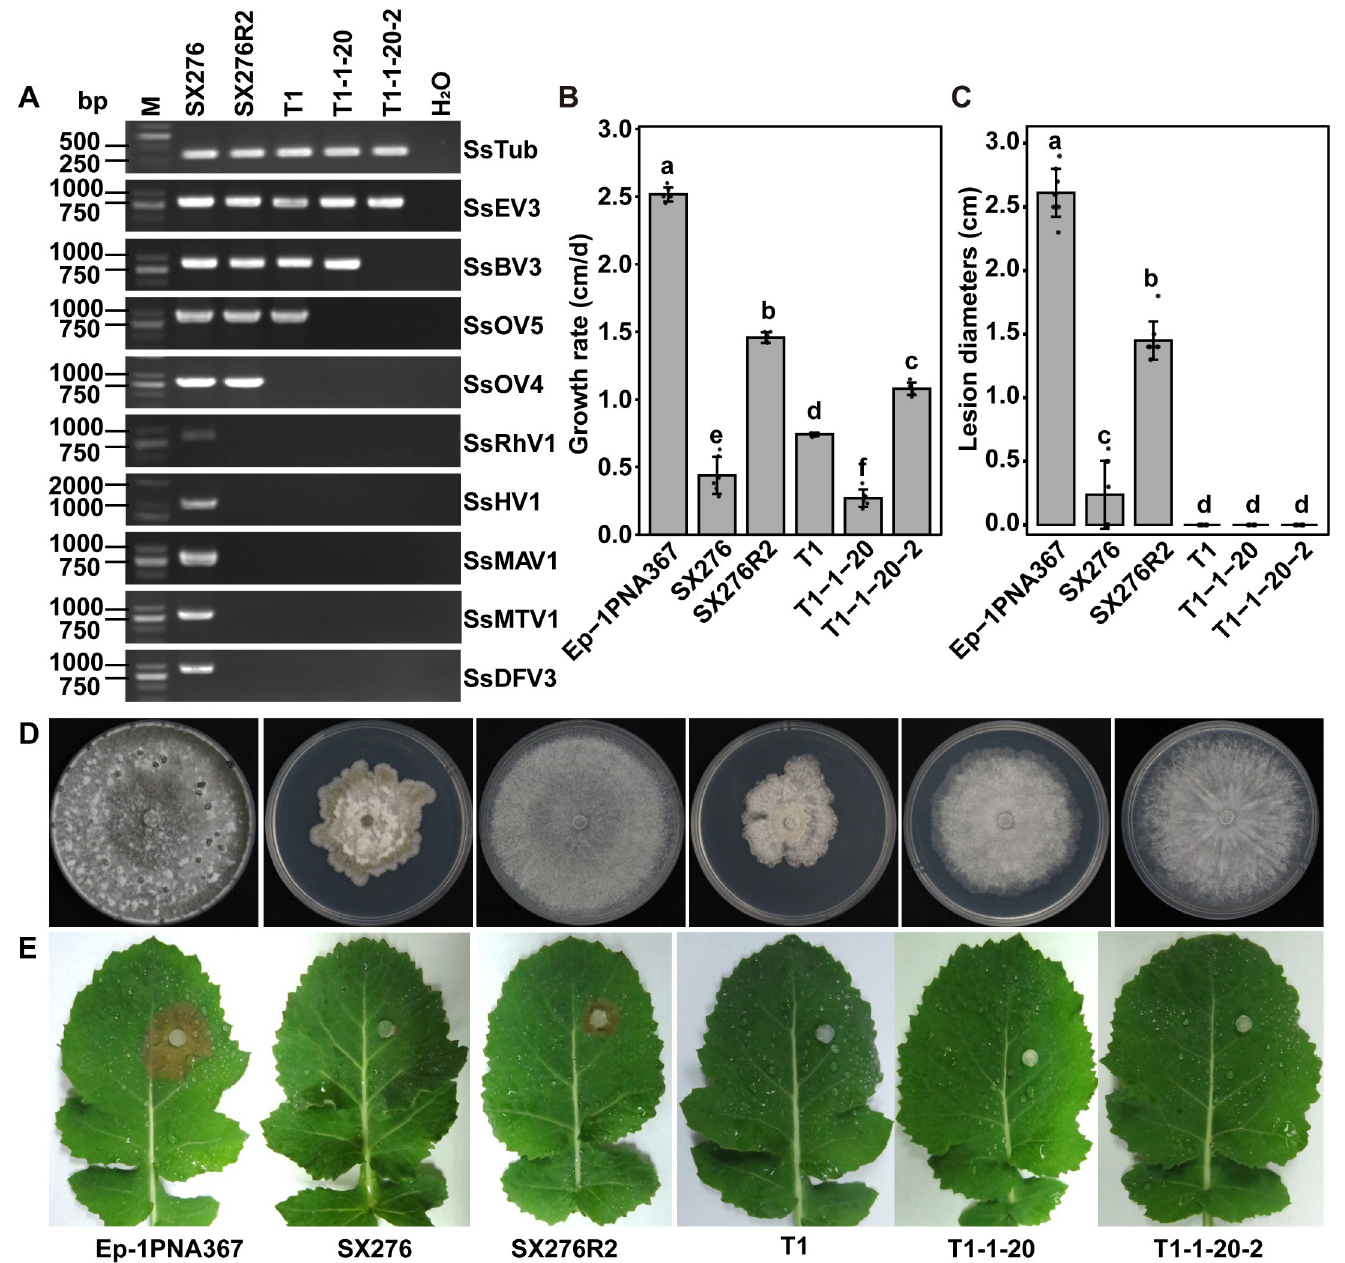
Fig 6. SsEV3 was responsible for hypovirulence on S . sclerotiorum . (A) Acquisition of regeneration strains through protoplasts of virus-cured method with ribavirin and cycloheximide. Strain SX276 is the original strain infected with nine viruses. Strain T1-1-20-2 was detected with a single virus SsEV3. (B) and (C) are the mathematical statistics of growth rate and diameter of leave lesion (48 h). Error bars indicate the SD from six sample means. The different letters on the top of each column showed a significantly difference at the P < 0.05 level of confidence according to the t-test. (D) The colony morphology of the strains and Ep-1PNA367(7 dpi). (E)The pathogenicity of individual isolates was